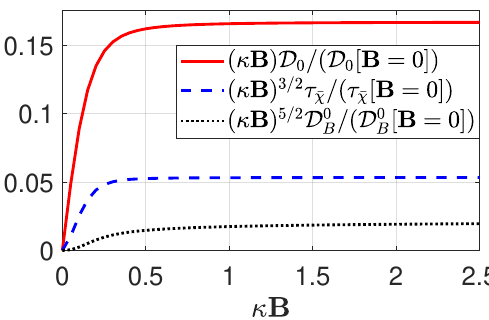
Figure 5. Normalised (cid:12)rst order TCs as functions of (cid:20) B when (cid:20) E = 0. f C (1) ; C (1) 2 4